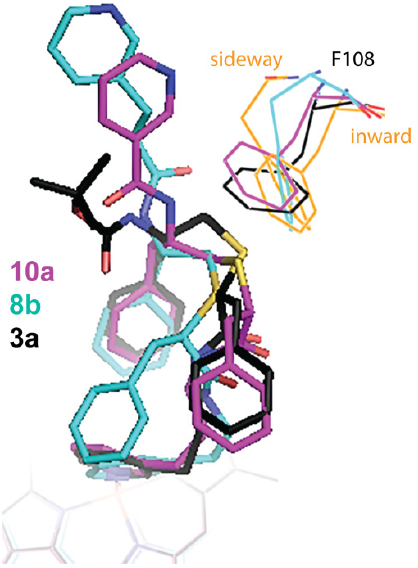
Figure 9. S– π interaction between the inhibitor backbone sulfur atom and Phe108. Only compounds with the elongated pyridyl–propyl head-linker, such as 10a , b and 3a , but not 8b , are positioned suitably for the S– π interaction between the backbone sulfur atom and the aromatic ring of Phe108. Due to intrinsic conformational heterogeneity of the Arg106-Pro110 fragment, Phe108 adopts a ‘sideways’ or ‘inward’ orientation (in orange; ligand-free 5VCC structure), which can be readjusted to optimize the aromatic overlap with the S-heteroatom. In 10b , the backbone and Phe108 positions are similar to those in 10a and are not shown for clarity.